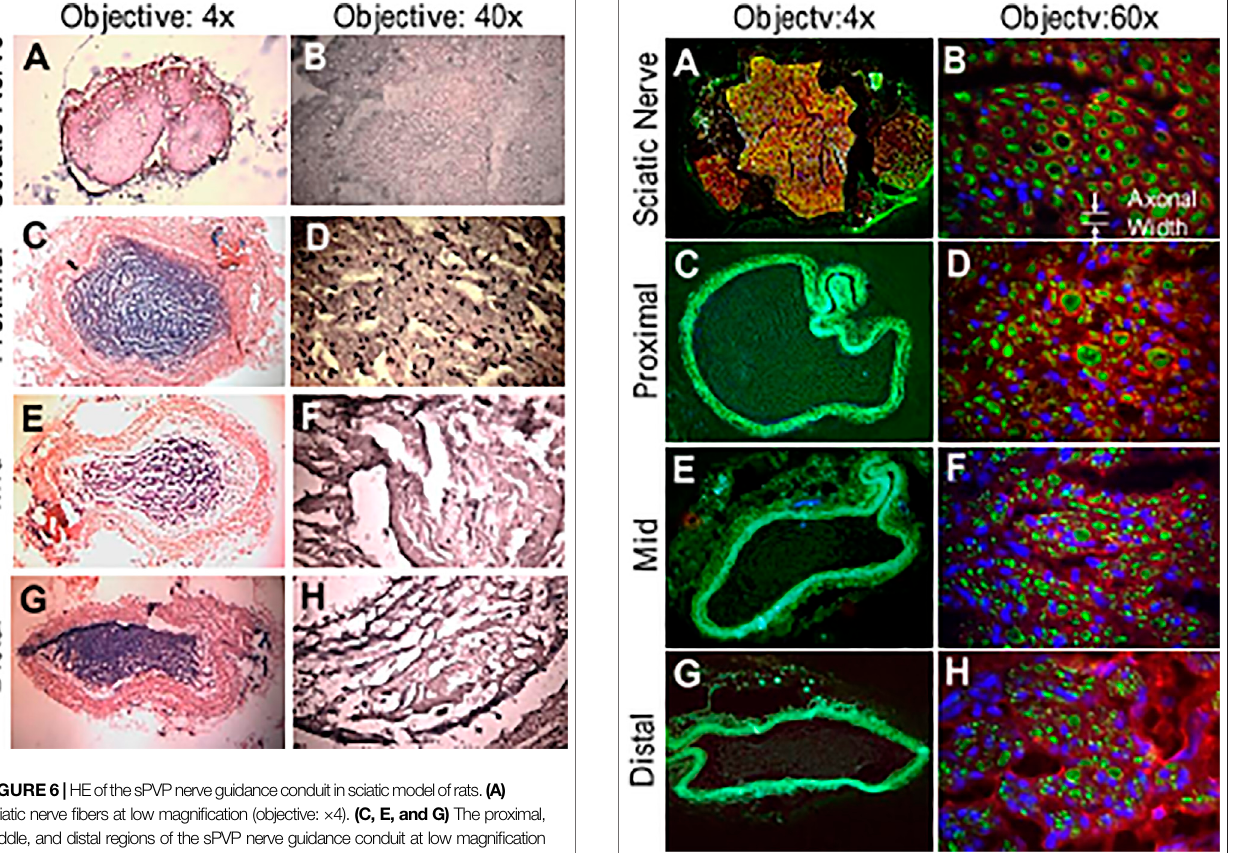
FIGURE 7 | Immuno fl uorescence images of the sPVP nerve guidance conduit in sciatic model of rats. (A) Sciatic nerve fi bers at low magni fi cation (objective: ×4). (C, E,andG) Theproximal,middle, and distalregionsofthesPVP nerve guidance conduit at low magni fi cation (objective: ×4), respectively. ( B) Sciatic nerve fi bers at high magni fi cation (objective: ×60). (D, F, and H) The proximal, middle, and distal regions of the sPVP nerve guidance conduit at high magni fi cation (objective: ×60), respectively. Red: anti-MBP (myelin basic proteins); green: anti-NFLP (neuro fi lament light polypeptide); blue: nuclei of cells. Objective: ×60. The white lines and arrows indicate the measurement of axonal